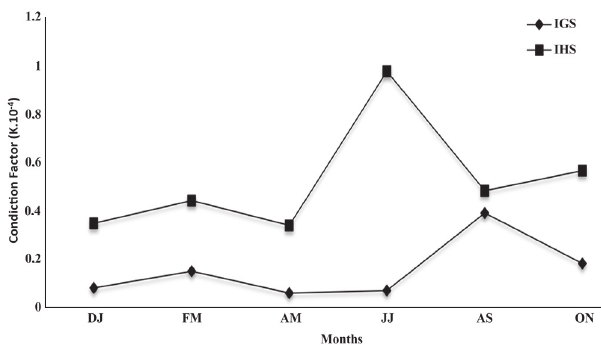
Fig. 9. Bimonthly variations in the gonadosomatic index (GSI) and hepatosomatic index (HSI) for Loricariichthys melanocheilus males in the rio Ibicuí, Rio Grande do Sul.